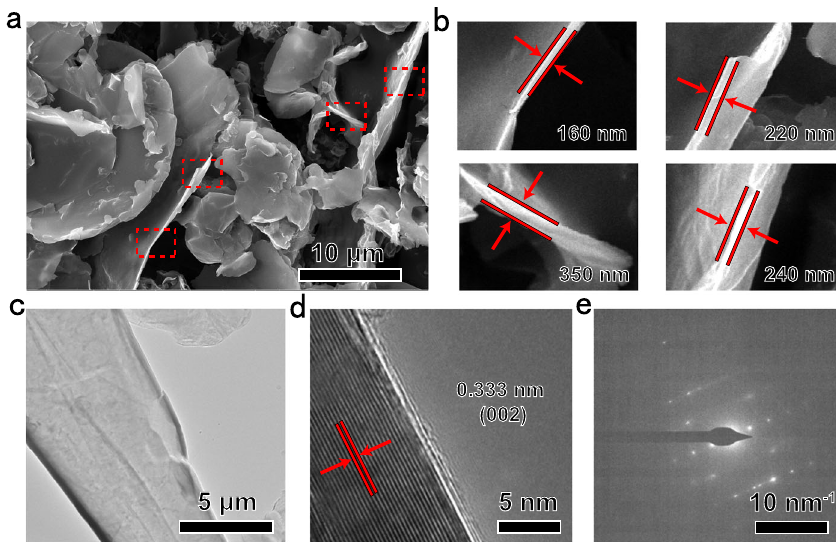
Fig. 2 Morphology and microstructure of graphite submicro fl akes. a , b SEM images. c TEM image. d HRTEM image. e SEAD